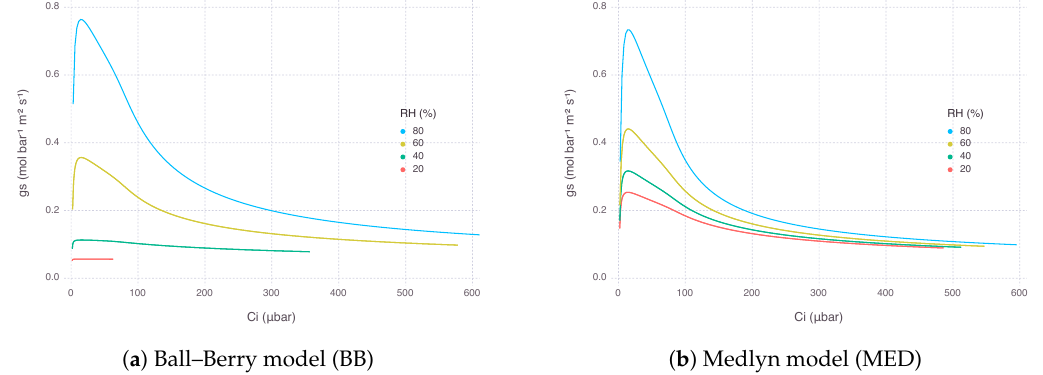
Figure 2. Stomatal conductance ( g s ) estimated by two stomatal conductance models over a range of atmospheric CO 2 concentration ( C a ) from 10µbar to 1500µbar at multiple levels of relative humidity (RH). The graph was plotted against resultant intercellular CO 2 concentration ( C i ). Air temperature ( T a ) was 32 ◦ C and irradiance ( I ) was 2000µmol quanta m − 2 s − 1 .